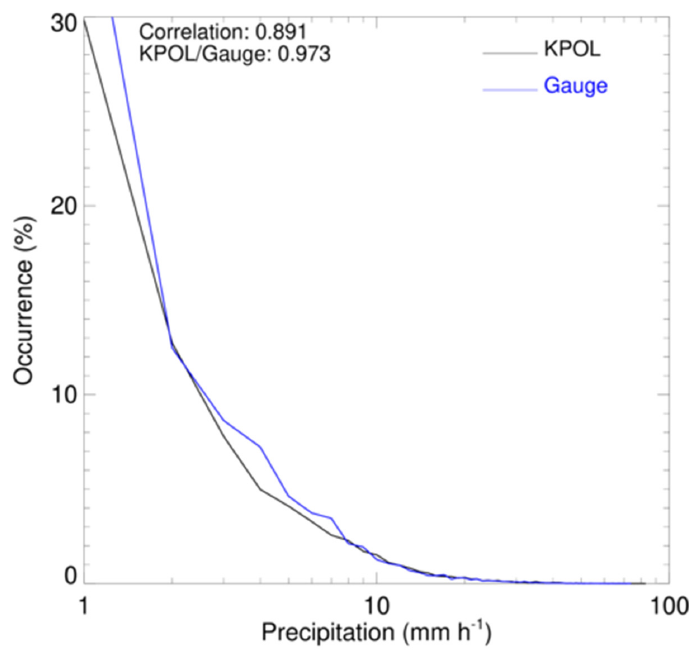
Figure 13. Precipitation occurrences from available gauge data over Kwajalein and KPOL for the period from April 2014 to April 2015. Gauge precipitation rates were selected from 10-min prior to KPOL volume scan time, to 10-min after the scan time. The KPOL precipitation average is from the nine 1 km × 1 km horizontal grids surrounding the gauge location. Zero rates are excluded from both gauge and radar averages.